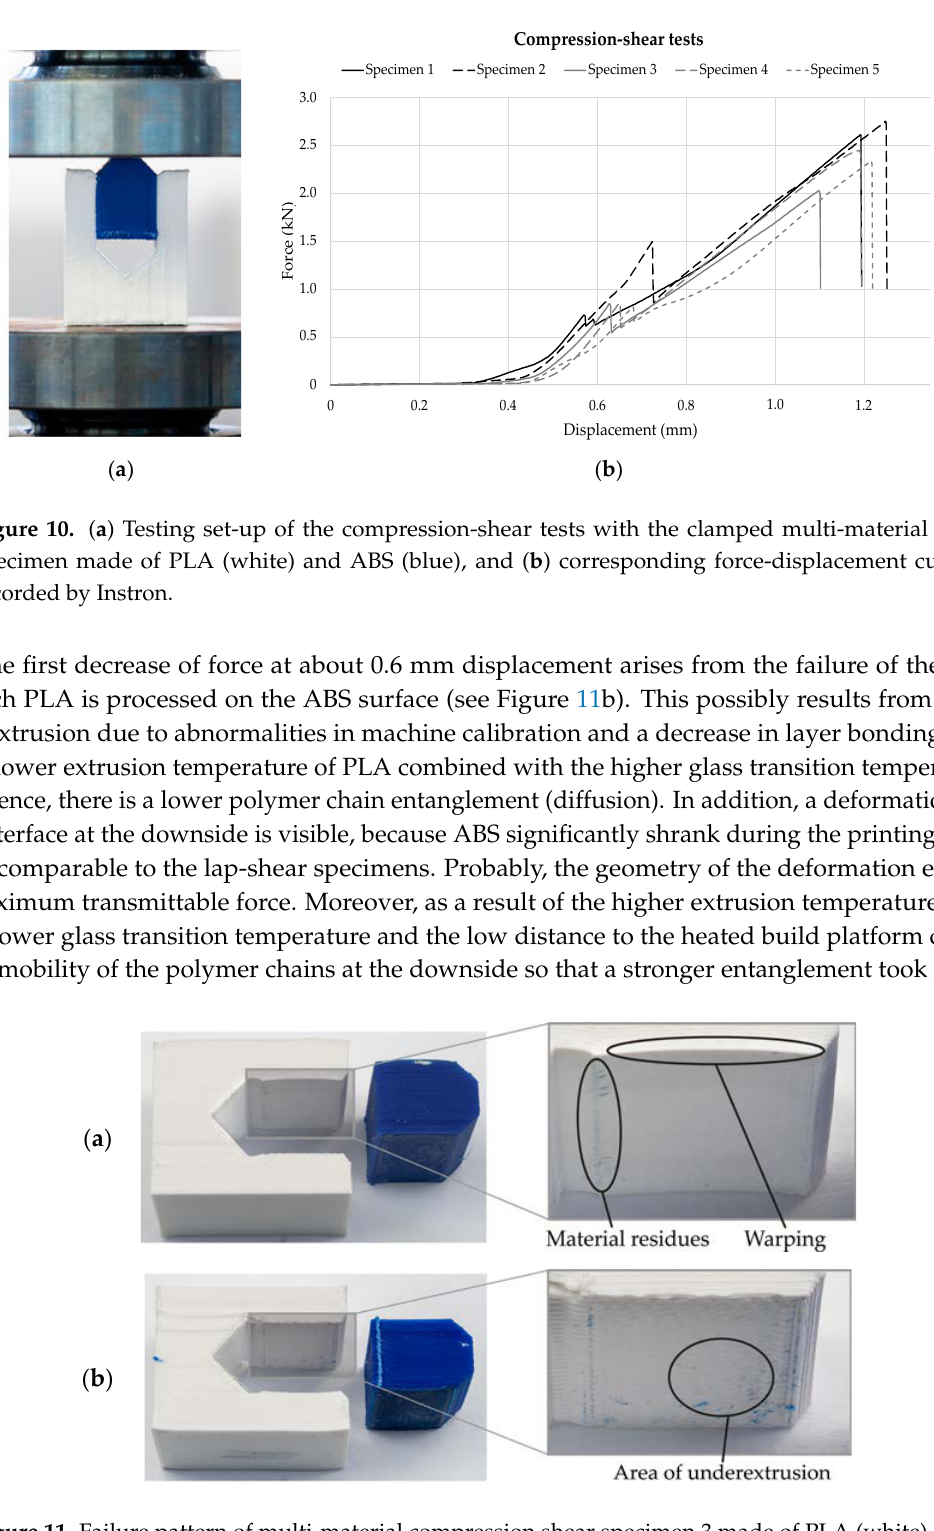
Figure 11. Failure pattern of multi-material compression shear specimen 3 made of PLA (white) and ABS (blue) at both interface on the downside ( a ) and on the upside ( b ) relating to the build direction.